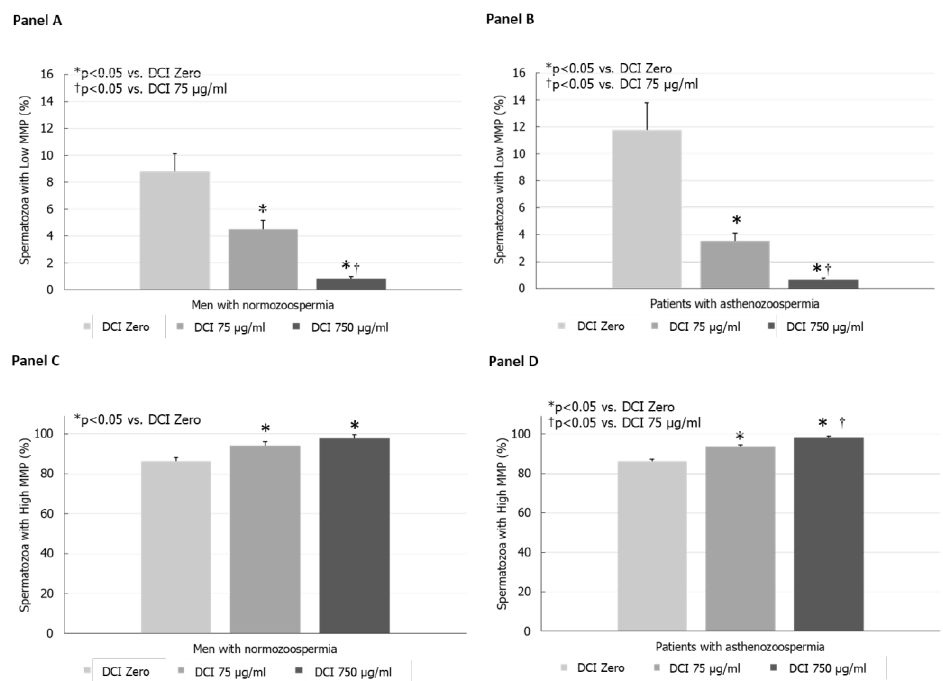
Figure 1. ( Panel A ) E ff ects of increasing concentrations of D-Chiro-inositol (DCI) on the percentage of spermatozoa with low mitochondrial membrane potential (L-MMP) in normozoospermic men. ( Panel B ) E ff ects of graded concentrations of DCI on the percentage of spermatozoa with high L-MMP in asthenozoospermic patients. ( Panel C ) E ff ects of graded concentrations of DCI on the percentage of spermatozoa with high mitochondrial membrane potential (MMP) in normozoospermic men. ( Panel D ) E ff ects of graded concentrations of DCI on the percentage of spermatozoa with high H-MMP in patients with asthenozoospermia.